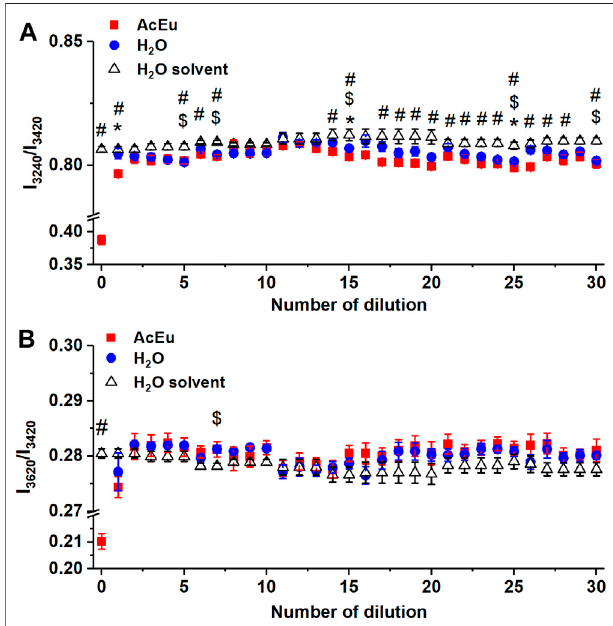
FIGURE 5 | Dependence of the intensity ratio of the Raman bands I 3240 / I 3420 (A) and I 3620 /I 3420 (B) on the number of dilutions of the initial AcEu solution and water. Daily water monitoring is also shown (free water molecules). * — statistically signi fi cant difference between AcEu dilution and the respective water dilution, # — statistically signi fi cant difference between AcEu dilution and water, $ — statistically signi fi cant difference between water dilution and water. The data are presented as mean ± se.